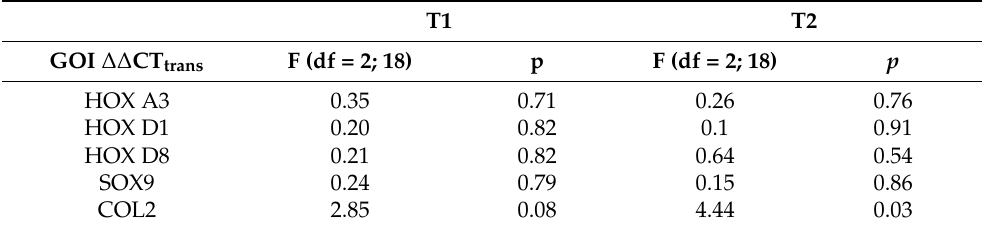
Table 6. Levene’s test with F-values and significance levels ( p ) for the time points T1 and